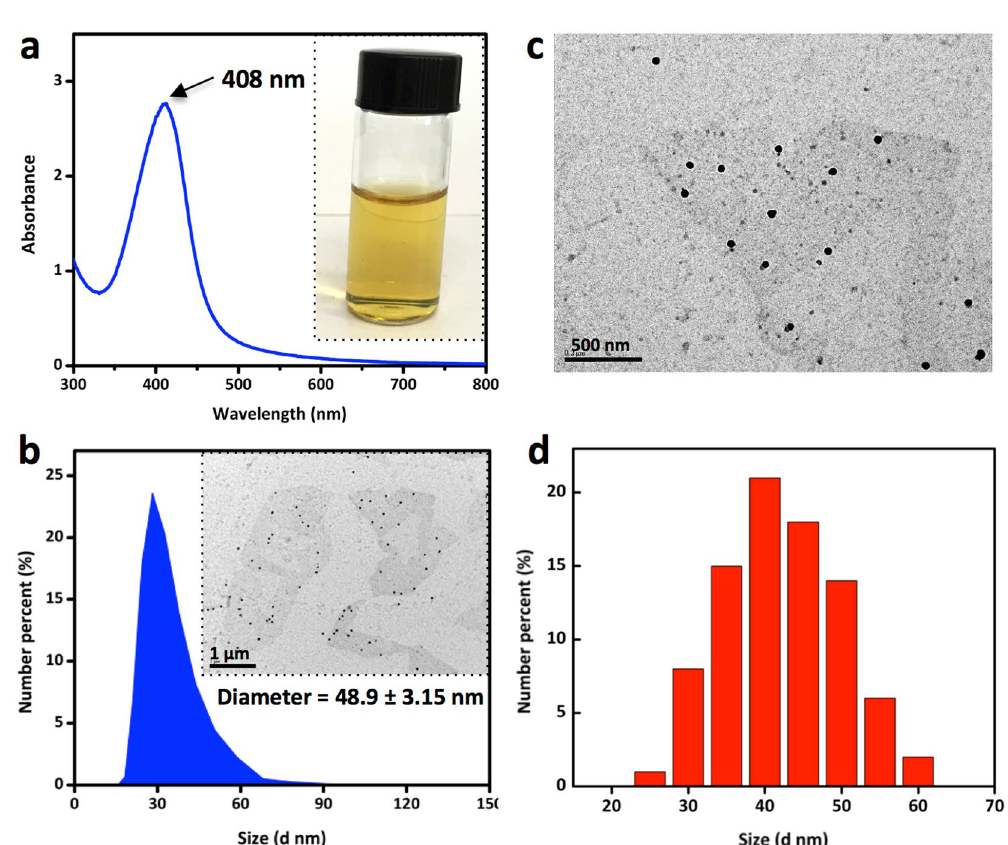
Figure 3. Dispersion property of CSS-Ag NPs solution. ( a ) UV-vis spectrum and optical photo of CSS-Ag NPs solution, ( b ) size distribution of CSS-Ag NPs measured by DLS, and insert shows a TEM image of CSS-Ag NPs, ( c ) TEM image of CSS-Ag NPs, ( d ) size distribution of CSS-Ag NPs measured by